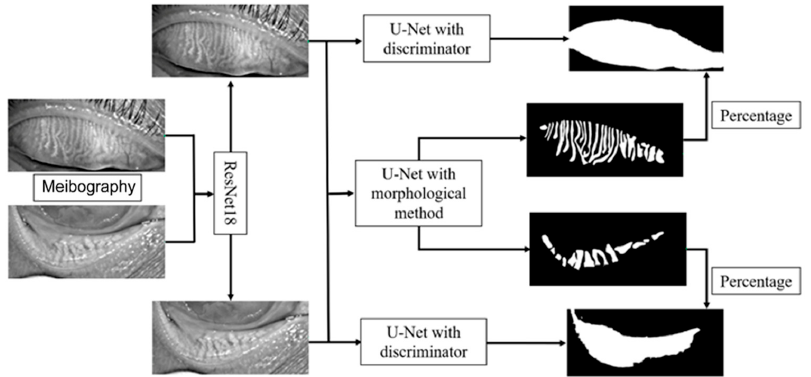
Figure 2. The framework of the deep learning model.